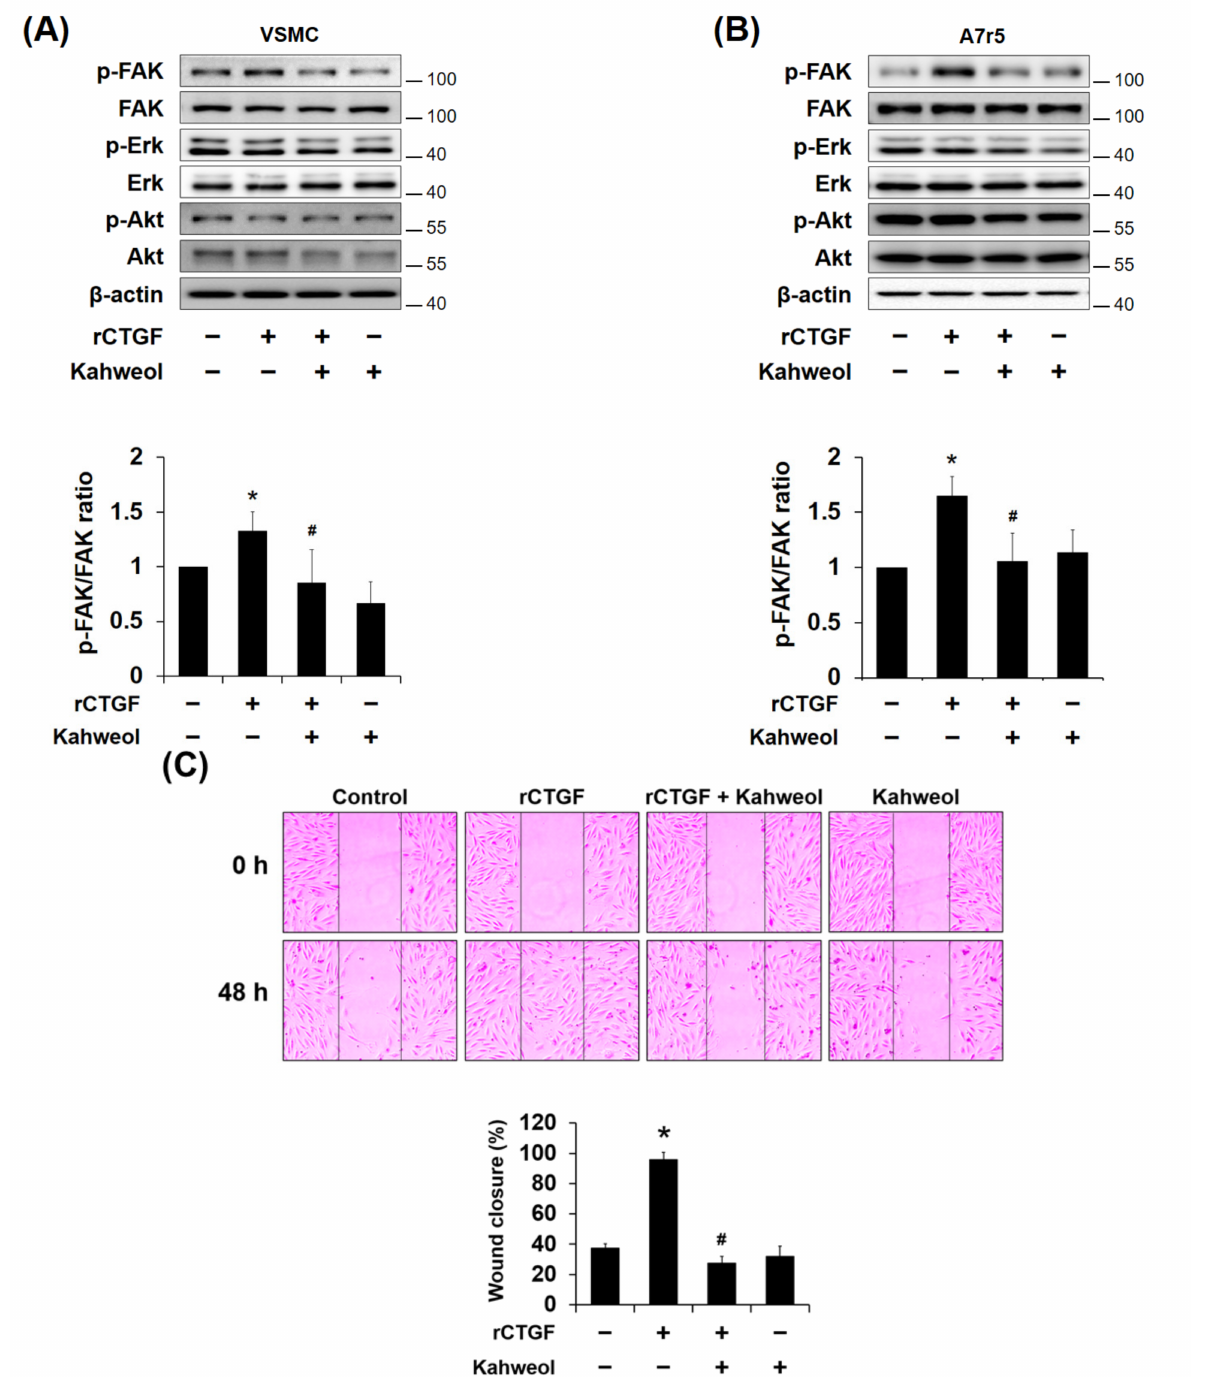
Figure 5. The involvement of FAK in the mechanism underlying the kahweol effect on migration in CTGF-stimulated VSMCs. ( A , B ) Cells were pretreated with rCTGF (50 ng/mL) for one hour and then treated with kahweol (10 µ M) for 24 h. Soluble lysates were subjected to Western blotting for FAK, Erk, and Akt. Protein levels of phosphorylated FAK, Erk, Akt, and β -actin were determined by Western blotting with specific antibodies. Bar graphs present the densitometric quantification of the Western blot bands. ( C ) Cells were scratched with a micropipette tip to form a cell-free (wounded) area and pretreated with rCTGF (50 ng/mL) for one hour and then treated with kahweol (10 µ M) for for 48 h. Wound areas were visualized using a phase-contrast microscope. The distance migrated was determined as the average of the distances of each cell from the wound boundary. Results are representative of three independent experiments. *, p < 0.05 vs. untreated control; #, p < 0.05 vs. rCTGF